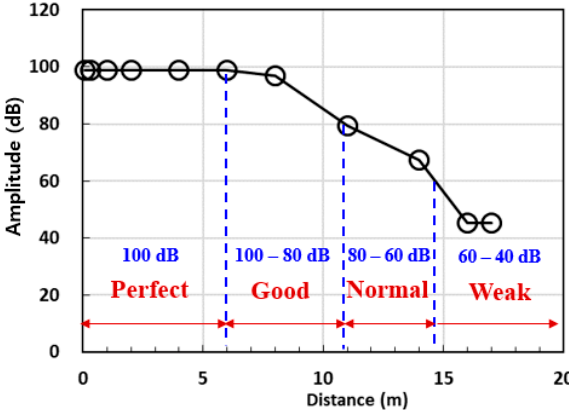
Figure 15. Four levels of signal reception based on AE signal intensity.